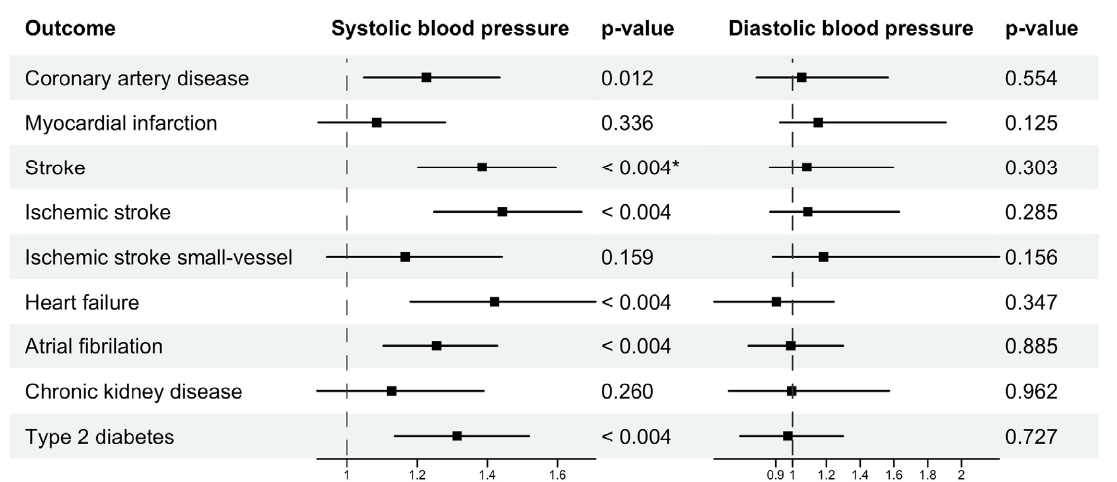
of DBP attenuated to zero for the outcomes (Figure 4). Table 2 summarises the results from two-sample MR and MVMR analyses.